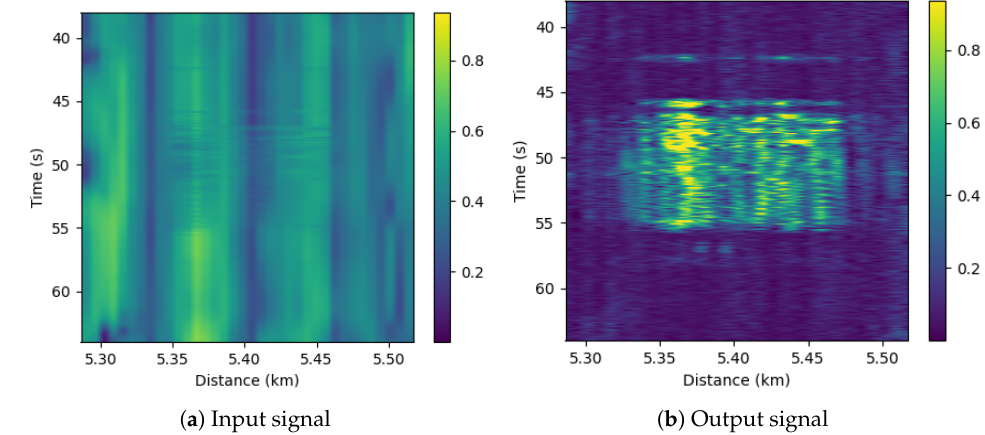
Figure 6. Comparison of the original and denoised signals around 5 km ditch for Hydraulic